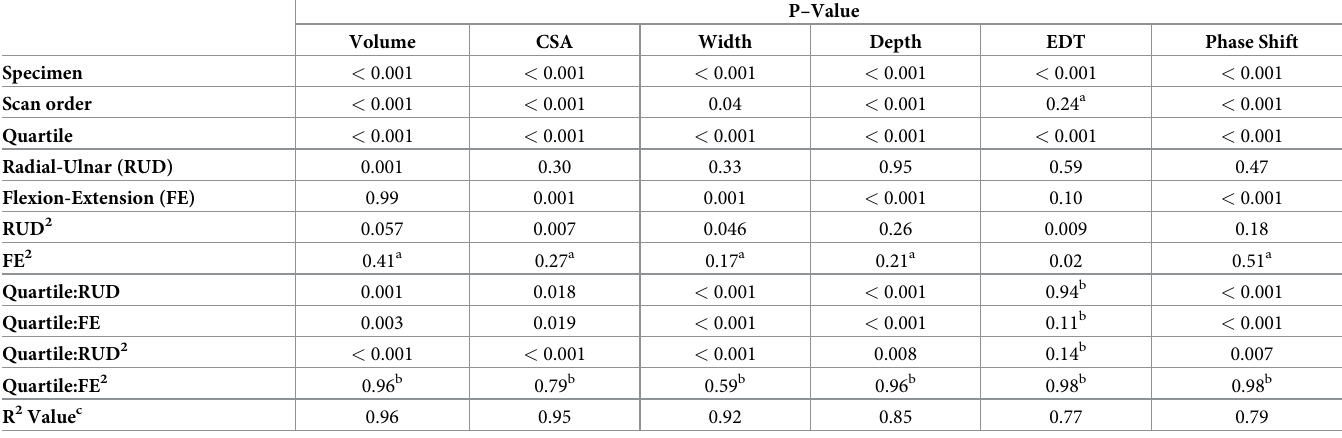
Table 1. P-values for each factor in the full multiple regression models of volume, cross-sectional area (CSA), width, depth, Euclidean distance from the template (EDT), and phase shift relative to the